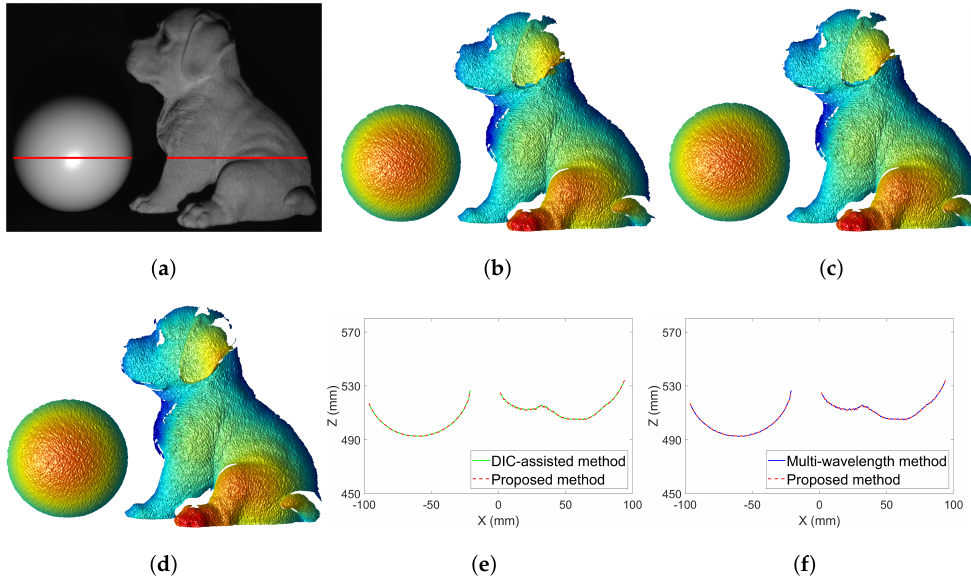
Figure 9. Three dimensional (3D) reconstructed shapes with the absolute unwrapped phase using different phase unwrapping methods. ( a ) Photograph of the 3D objects with the red line being the cross − section we examined. ( b ) 3D reconstruction using the unwrapped phase map shown in Figure 7c. ( c ) 3D reconstruction using the unwrapped phase map shown in Figure 7f. ( d ) 3D reconstruction using the unwrapped phase map shown in Figure 8a. ( e ) Overlap of the same cross − section of the reconstructed 3D shapes in ( b , c ). ( f ) Overlap of the same cross − section of the reconstructed 3D shapes in ( c , d